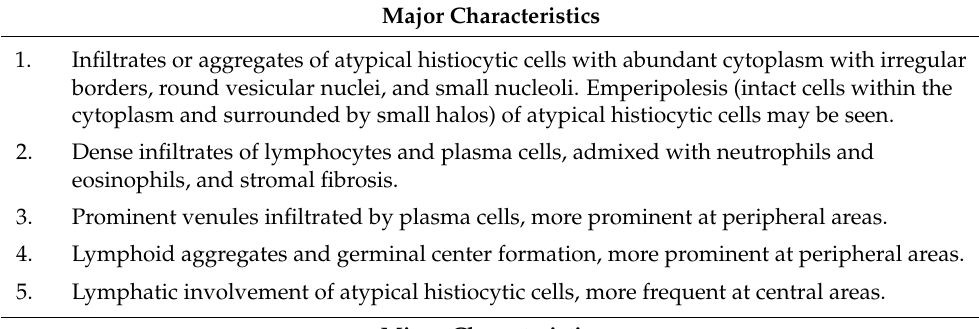
Table 2. A histologic summary of cutaneous Rosai–Dorfman disease (modified from reference